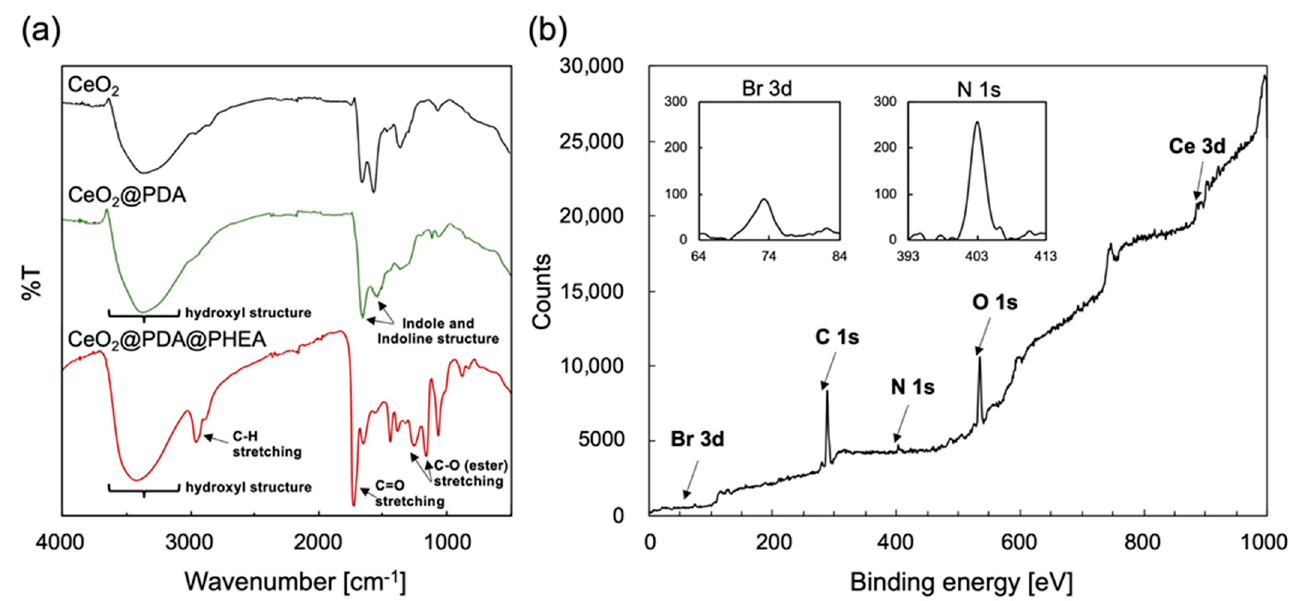
Figure 2. ( a ) IR spectra for the CeO 2 , CeO 2 @PDA, and CeO 2 @PDA@PHEA particles. ( b ) XPS spectrum for the CeO 2 @PDA particles. Insets show the XPS narrow-scan spectra for Br3d (left) and N1s (right).